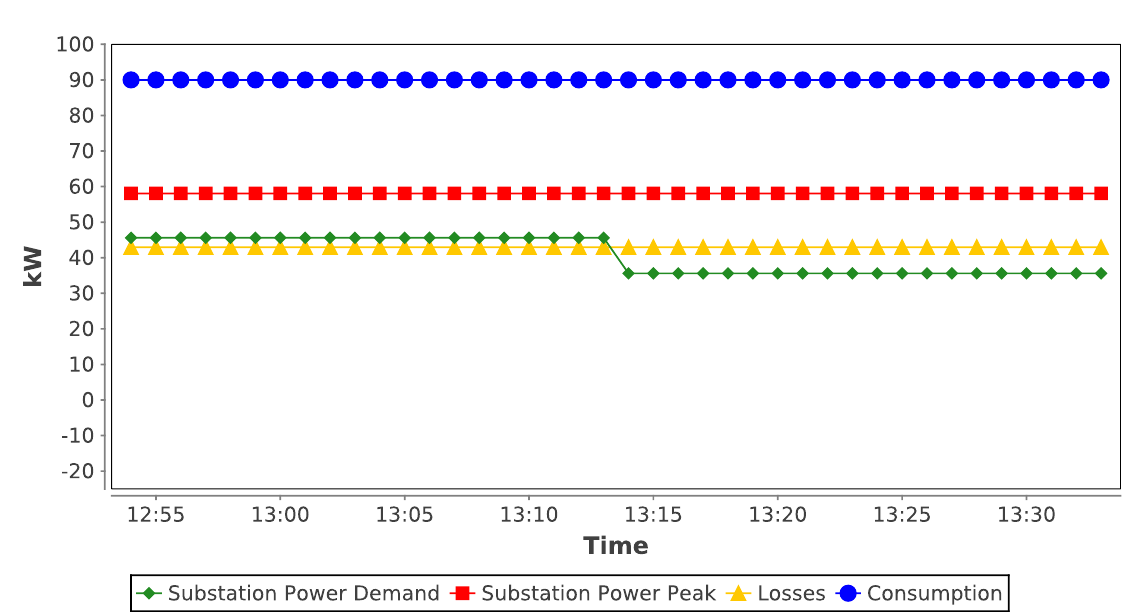
Figure 14. Demand from the substation when control is